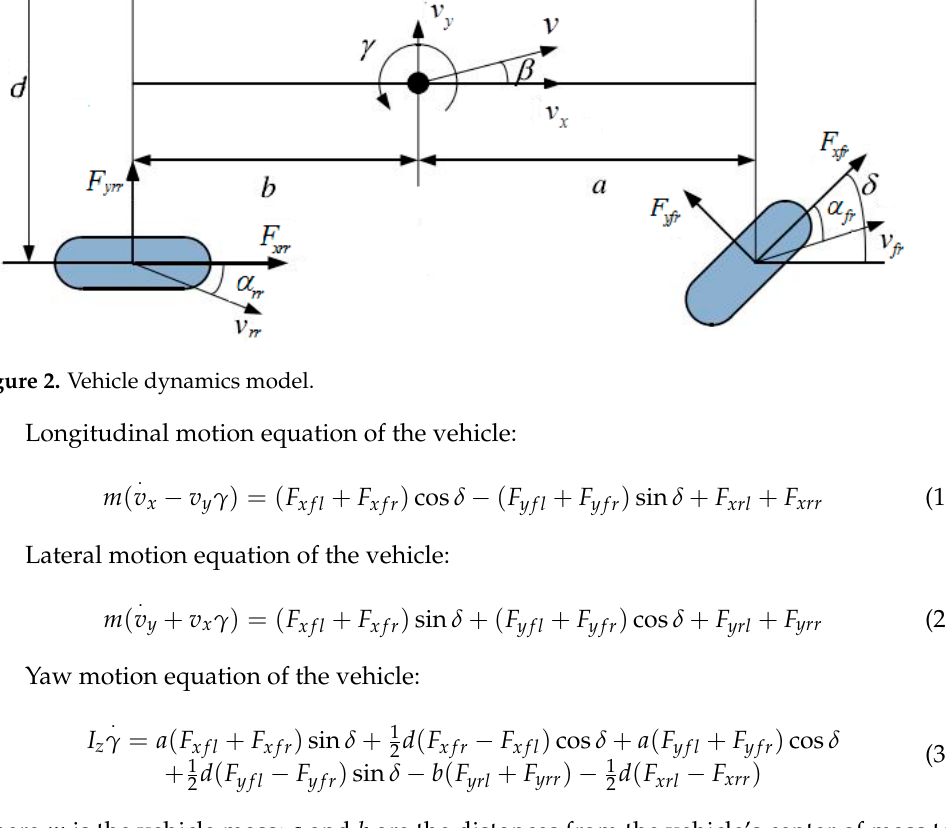
v , v and γ are the lon- x y